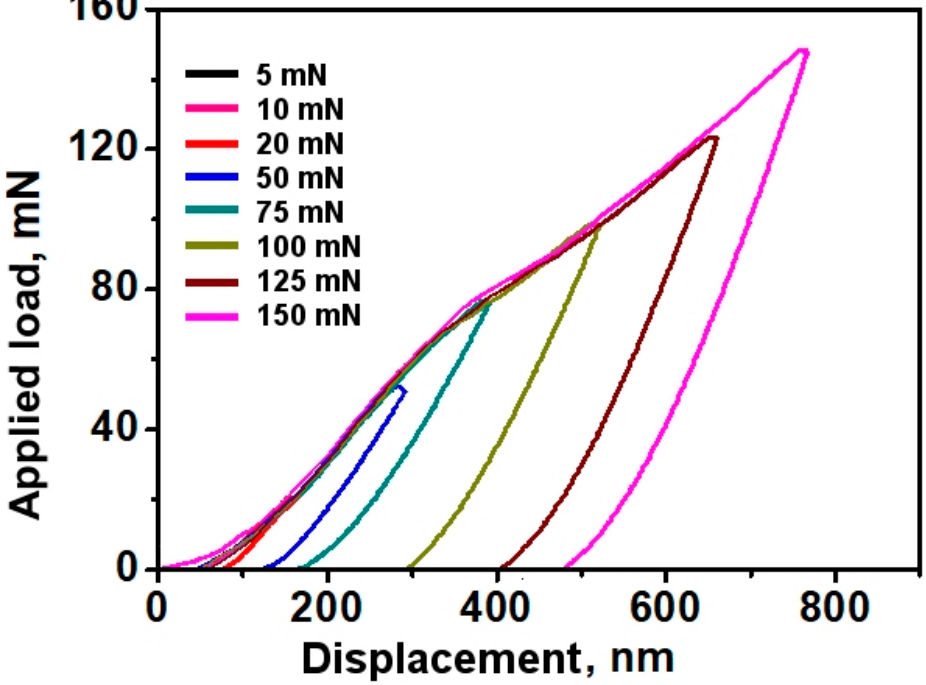
Figure 9. Typical load-unload curves, resulting from several nano-hardness tests. Observing the “load-unload” curves seen in Figure 9, it is possible to verify that the deepness reached in the hardness test was just a little higher than 10% of the coating thickness, showing that there was practically no influence of the substrate in the test. In fact, looking at Figure 9, the slopes of the curves are very similar, meaning that the substrate had no influence on the presented hardness value.